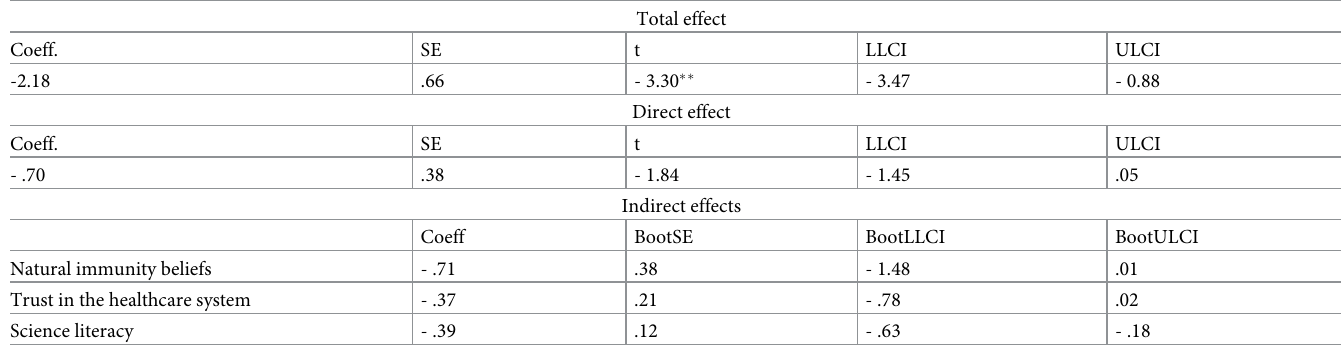
Table 7. Vaccine conspiracy beliefs—Mediation